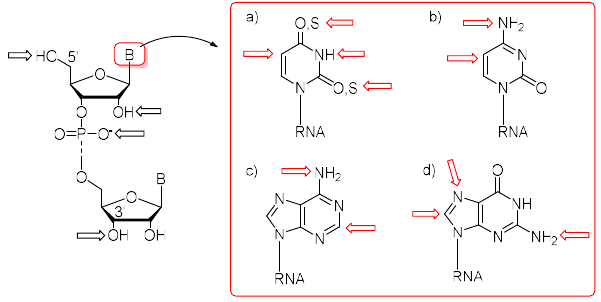
Figure 3. Representative sites of post-synthetic modifications present in sugar–phosphate backbone and nucleobase residues with the highlighting of uridine and thiouridine ( a ); cytidine ( b ); adenosine ( c ); and guanosine ( d ).